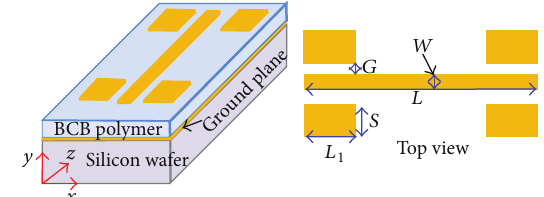
Figure 1: The studied back-to-back GCPW-MS-GCPW transitions with and without via-holes ( 𝑊 = 54 𝜇 m, 𝐺 = 25 𝜇 m, 𝐿 = 1cm, 𝐿 1 = 1mm, and 𝑆 = 1